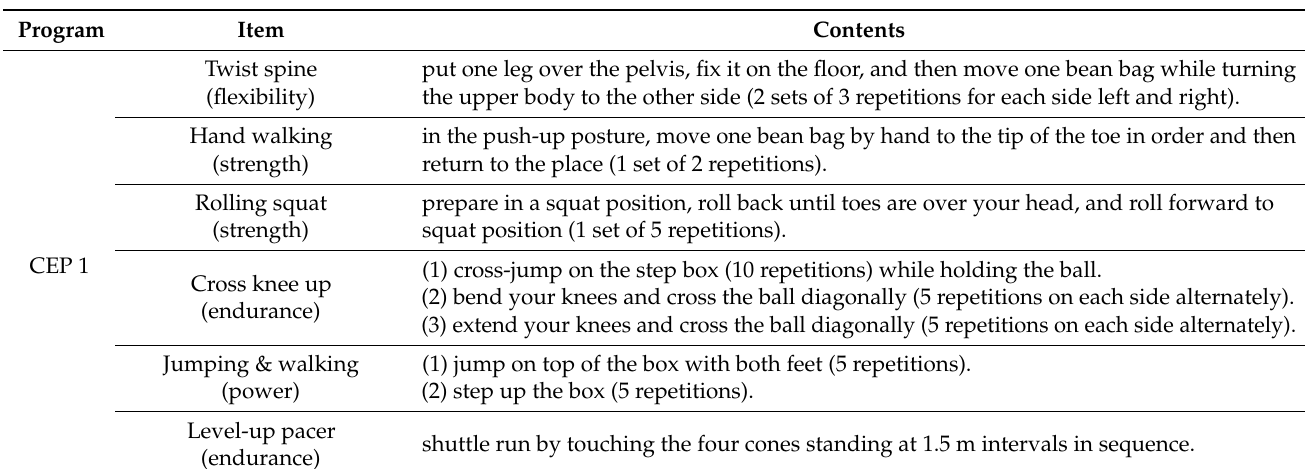
Table 2. Methods of circuit exercise